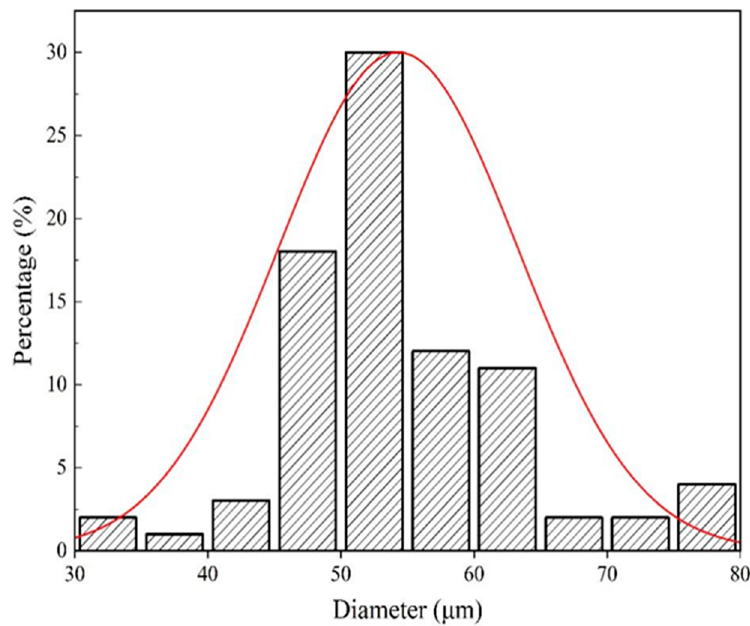
Figure 4. The size distribution of Al-Li alloy microparticles.